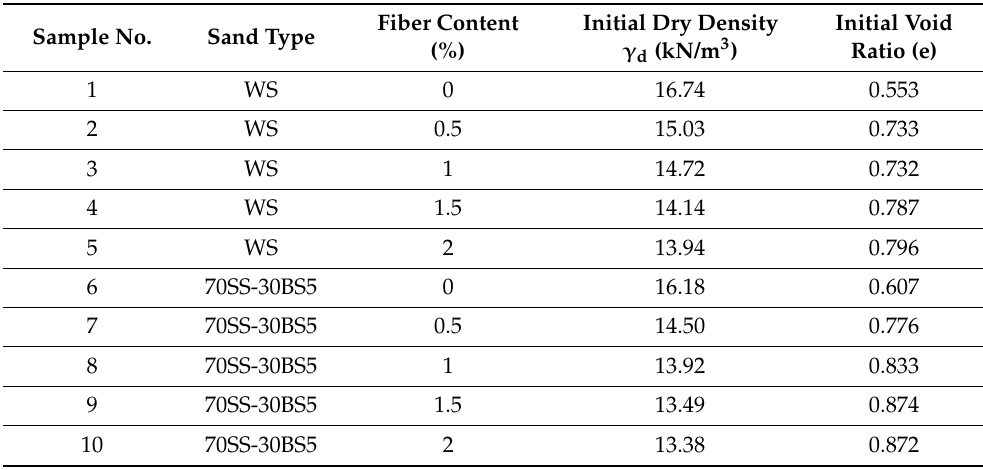
Figure 3. Schematic sketch of Hardin-type resonant column. Table 2. Testing program and specimen details (additional tests are presented here, the majority of the samples used in the study were presented in the form of tables by